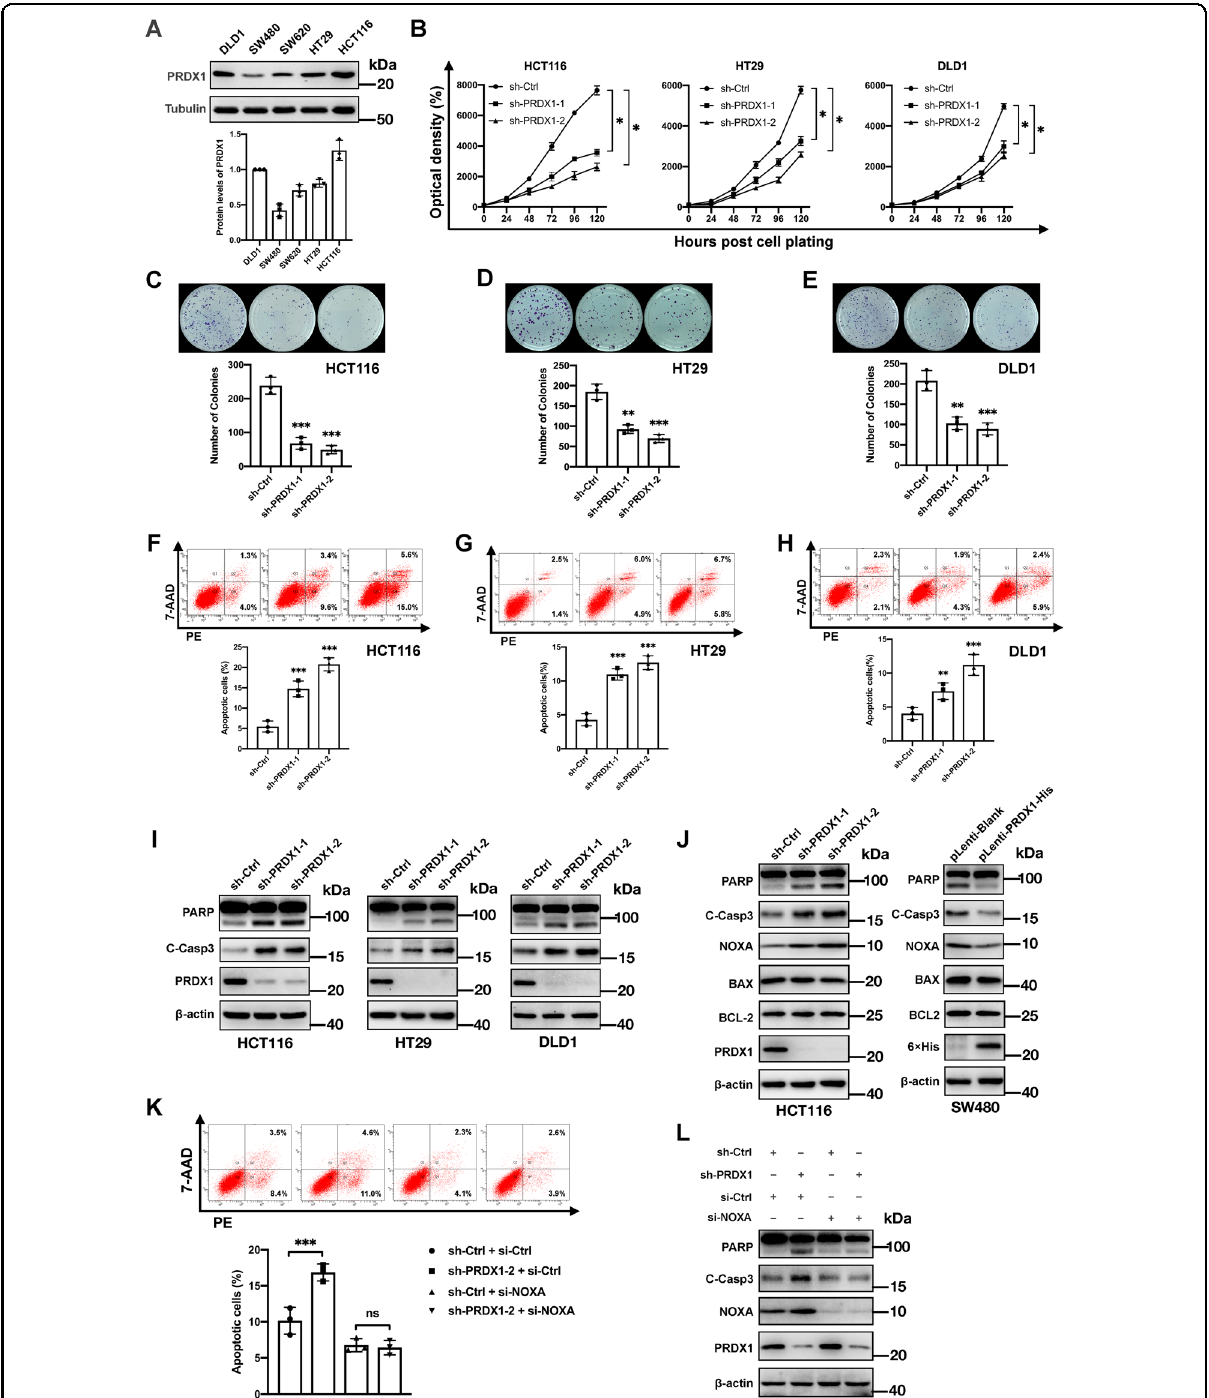
Silencing of PRDX1 in HCT116 cells signi fi cantly